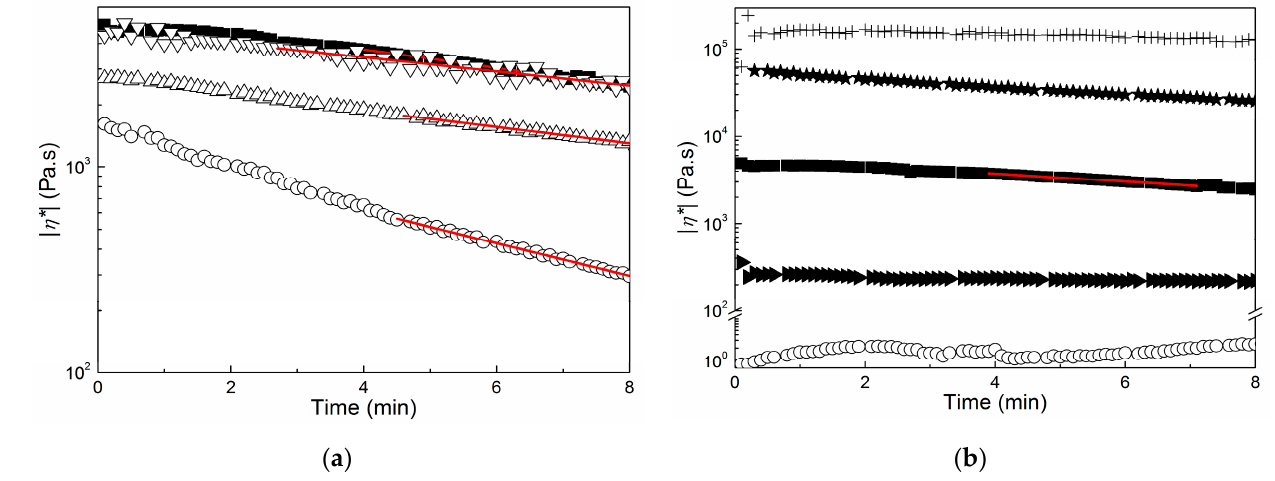
Figure 7. Time dependence of the dynamic shear viscosity | η *| measured at 1 Hz and 170 °C. ( a ): Sample F (squares), sample E (circles), sample D1 (up triangles) and sample D5 (down triangles); ( b ): sample F (squares), sample C1 (circles), sample C5 (right triangles), sample B (stars) and sample A (crosses). Lines are Arrhenius fits to the data.